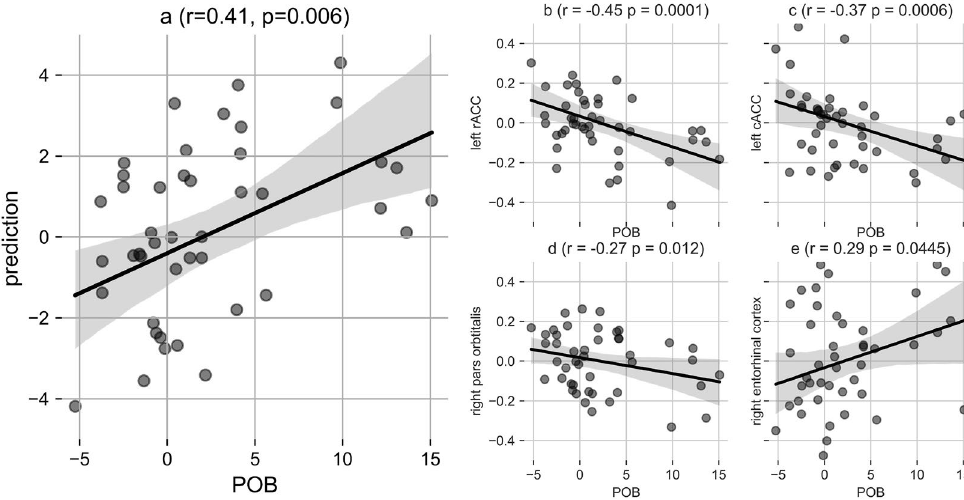
Figure 3. Predictions for personal optimism bias (POB). ( a ) The scatter plot with regression line is presented for prediction versus actual POB scores, ( b – e ) indicate predictive regions. For b – e , age was regressed out from each of the regions. 10,000 surrogate combinations were tested to generate the p -value ( p ) for the Pearson’s